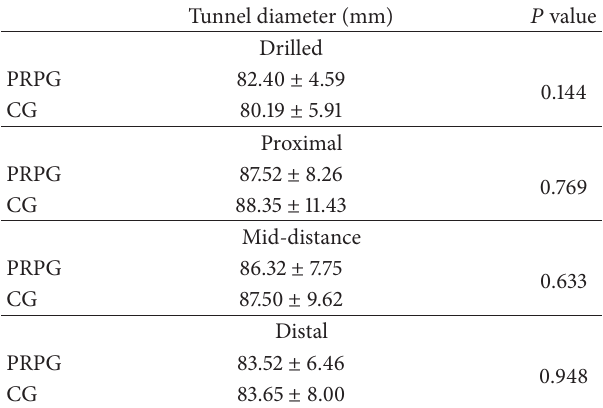
Table4:Comparisonoftunneldiameterbetweengroupsatdifferent locations one year